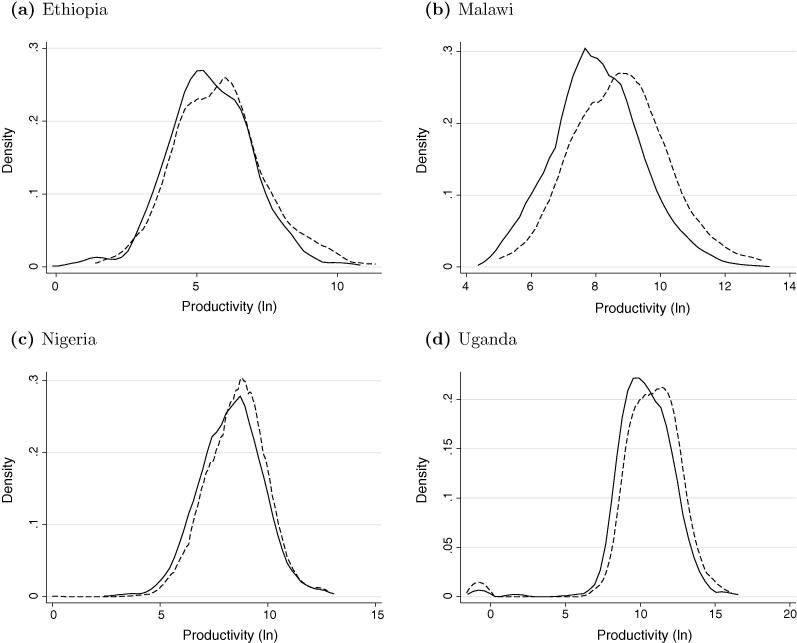
Productivity dispersal – by shock experience. Note(s): In (a)–(d) the continuous lines represent the productivity of enterprises where the corresponding household experienced a shock during the 12 previous months and the dotted lines the productivity of enterprises where the corresponding household did not experience a shock. Authors’ own calculations based on LSMS-ISA data.